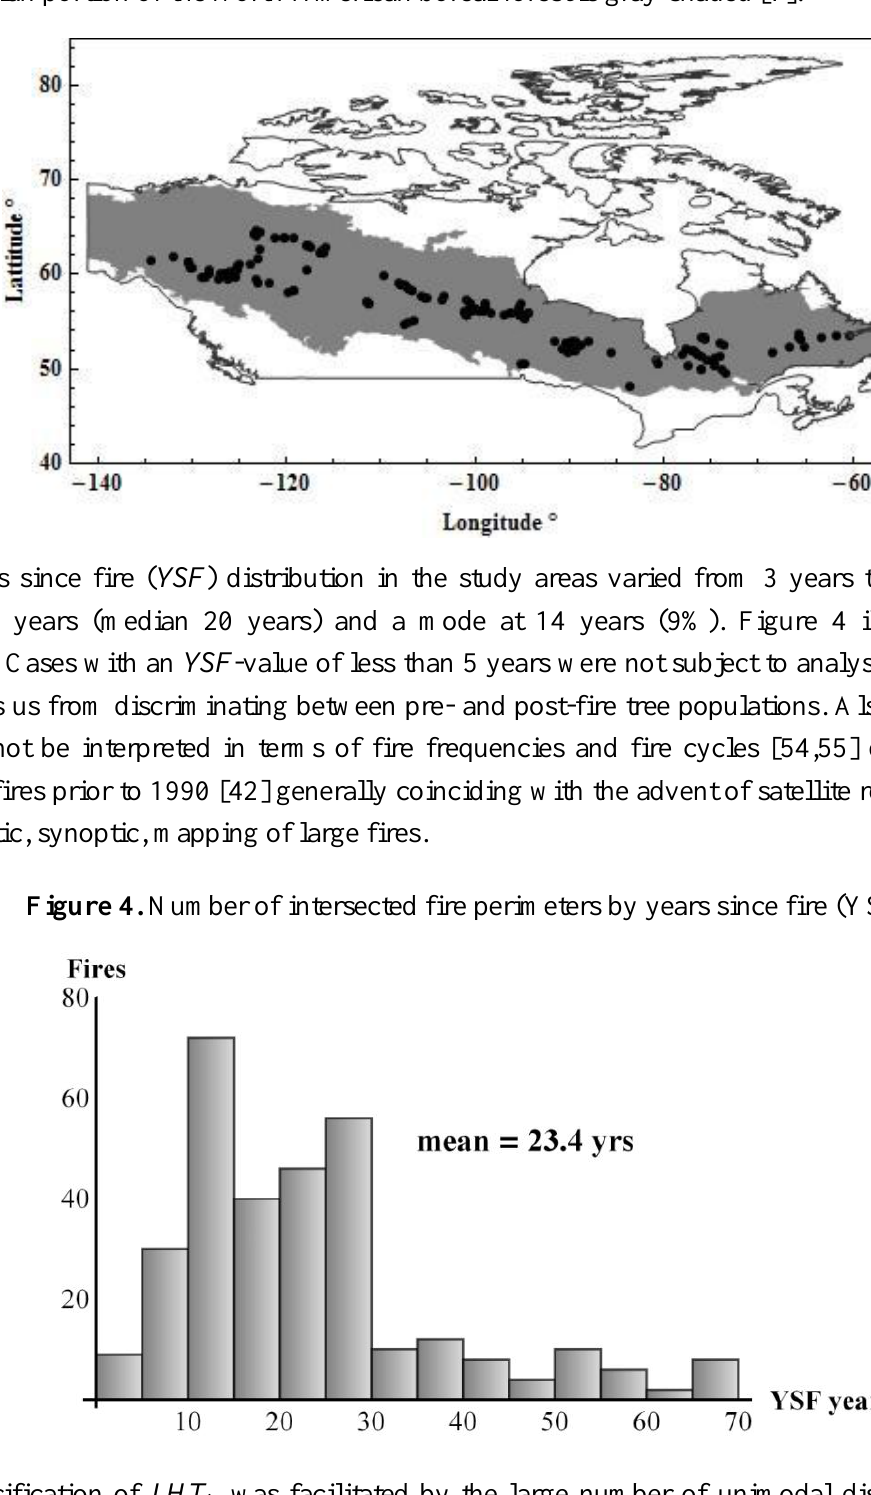
Figure 3. Location map of centroids of intersected fire perimeters (black dots). The Canadian portion of the North-American boreal forest is gray-shaded [7].